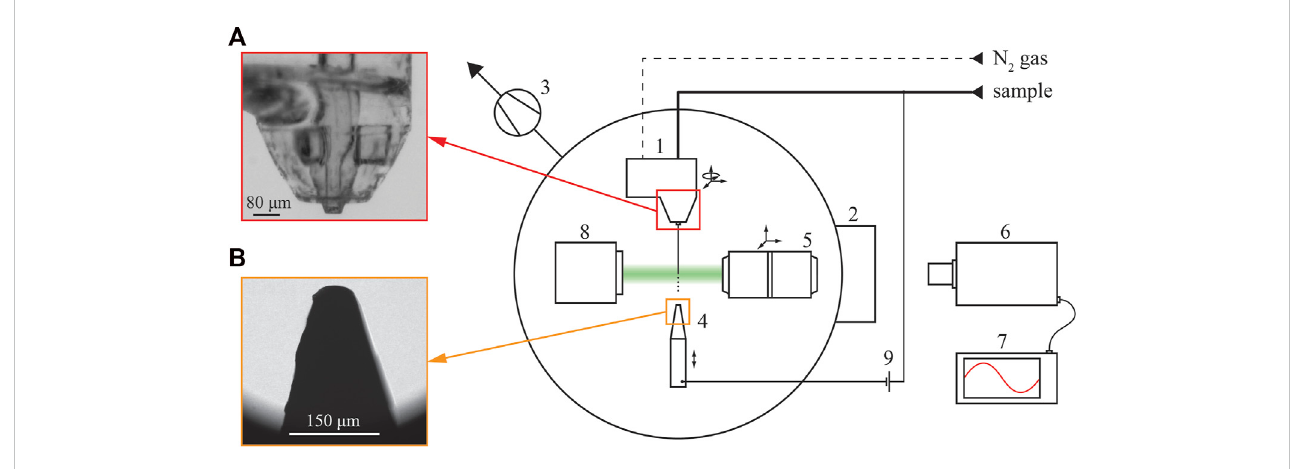
FIGURE 1 Schematic of the experimental setup for fl ow-focused micro-jets in the electric fi eld located at CFEL, Hamburg. An optical image detail (A) provides a close-up of the GDVN while (B) shows the exposed electrode tip. Ice can be seen forming on the electrode as the irregular contour on the